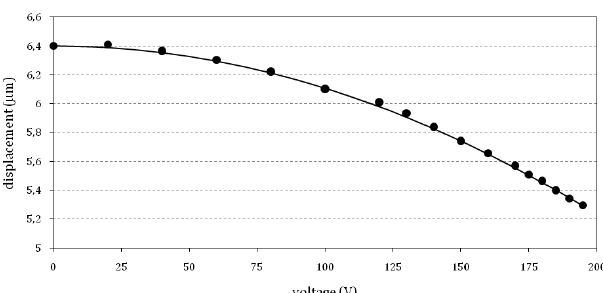
Figure 5: Static voltage-displacement conversion curve for the tensile loading device from FEM simulations (continuous line) and measurements (black dots).